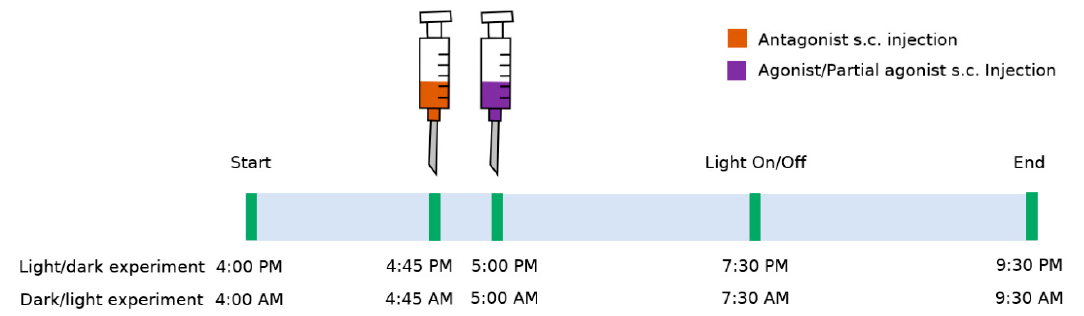
Figure 6. Schematic representation of the experimental design. Body temperature (T b ) has been recorded every 15 min. For light–dark phase experiments, light was off at 7:30 p.m., whereas for dark– light phase experiments, light was on at 7:30 a.m. s.c.: subcutaneous.